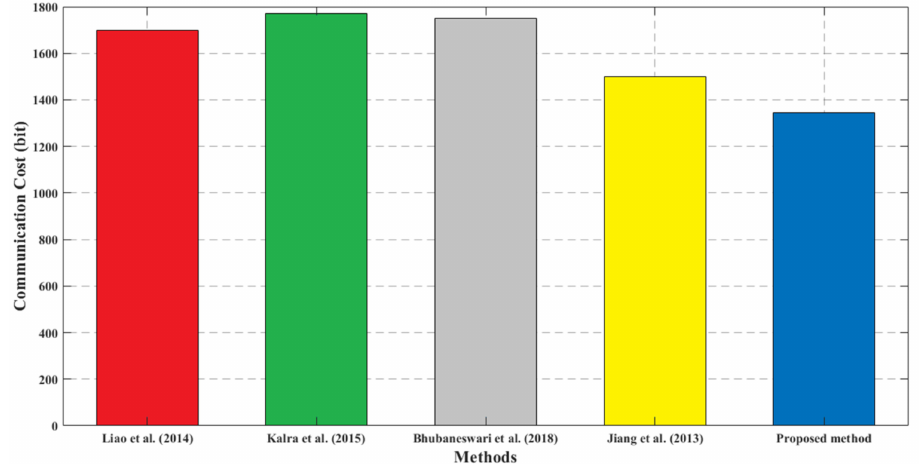
Figure 4. Communication